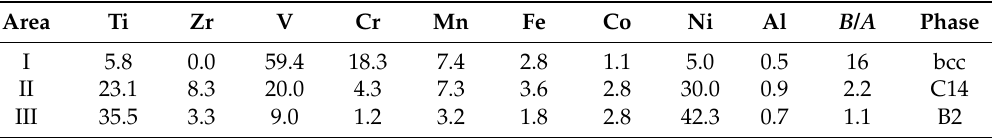
Figure 9. SAED patterns from Phase II of Alloy P7 that fit ( a ) a C14 structure in the [100] zone axis and ( b ) a face-centered cubic (fcc) structure with a ≈ 11 Å in the [110] zone. Based on the SAED patterns, Phase I (bcc) and Phase III (B2) were very close in orientation. Such alignments were present in more than one region, demonstrating a clear relationship in the crystal orientations between Phase I and Phase III. Based on the morphology of phases in Alloy P7, formation of the phases can be understood. Initially there is the dendritic growth of Phase I (bcc) and at the end of this growth, Phase I is surrounded with a liquid of modified composition. The composition of the liquid allows both Phase II (C14) and Phase III (B2) (and occasionally the fcc phase) to solidify from the liquid. In the case of the Phase III formation, it can be expected that the phase will grow coherently into similar structures, though they are slightly different in lattice parameters. However, if Phase II (C14) is formed first on Phase I (bcc), with a certain orientation determined by their structural relationship, it is expected that the formation of Phase III on Phase II will maintain the same structural relationship and orientation as Phase I/Phase II. Thus, Phase I and III will have very similar orientations. Further study is required to identify which mechanism or both play a role. However, in either case, the boundaries between the contacting phases are crystallographically clean and free of amorphous regions, which are easy to target during the initial formation in alkaline electrolyte, due to preferential etching in the grain boundary [28]. This type of clean interface can certainly facilitate the transportation of protons in the bulk of the alloy, which can be inferred from the relatively high diffusion coefficient ( D ) of Alloys P1–P8 (1.0–1.5 × 10 − 10 cm 2 ·s − 1 ) compared to a typical AB 2 multi-phase MH alloy (<1 × 10 − 10 cm 2 ·s − 1 ) [29]. The D value can be further increased to 2.13 × 10 − 10 cm 2 ·s − 1 with an annealing at 900 °C for 5 h [10]. As elaborated in a recent paper devoted to the discussion of the synergetic effect in electrochemistry [17], a clean interface is necessary not only to transport protons freely, but also to have excellent electron conductivity. At the end of discharge, there is still some MH phase left on the side with a larger work function (M1 in Figure 14b in [17]), which will act as a nucleation center for the next hydrogenation process. With an elastically connected grain boundary, the stress from MH on the M1 side will enlarge the lattice constant of the M2 side (hydrogenated)